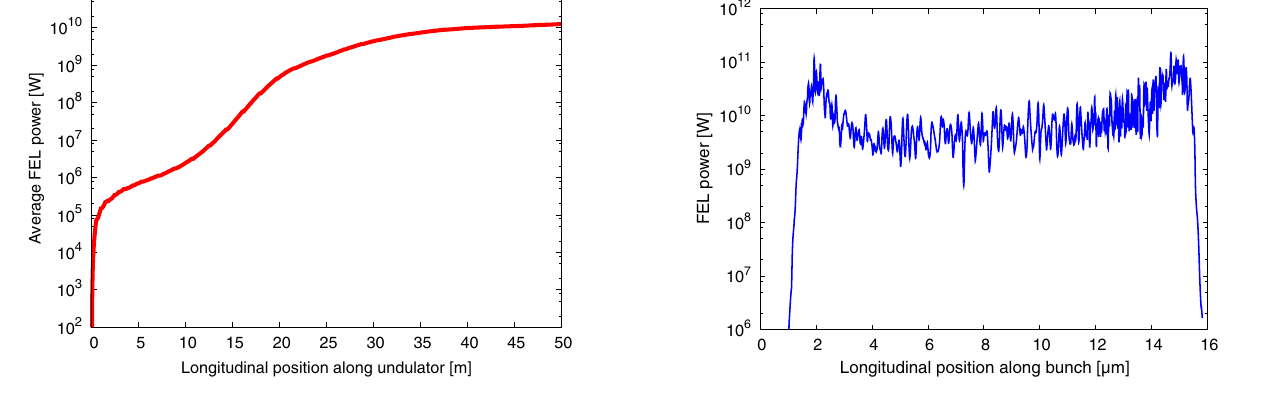
FIG. 8. FEL power evolution along the undulator. FIG. 9. FEL power temporal profile at undulator 40 m.